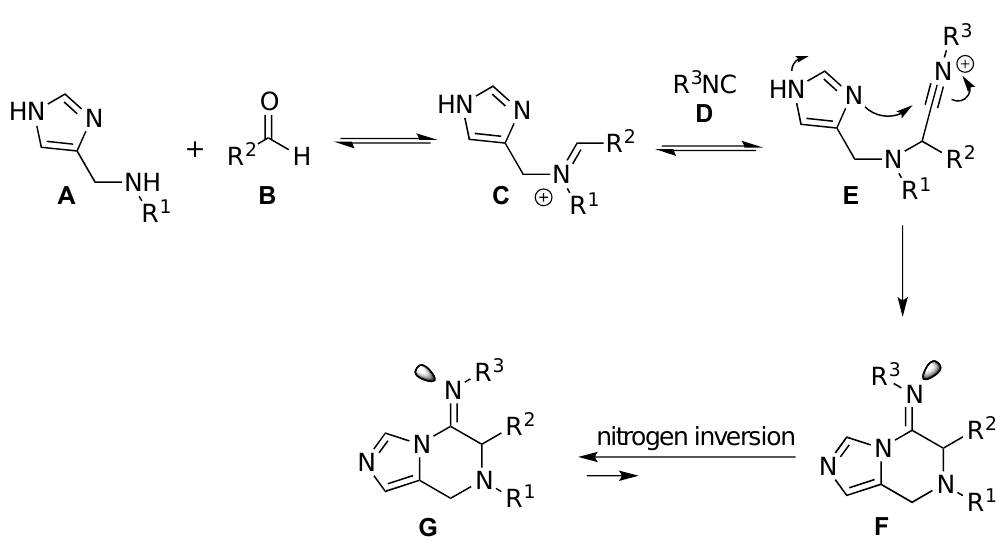
Scheme 3. Proposed reaction